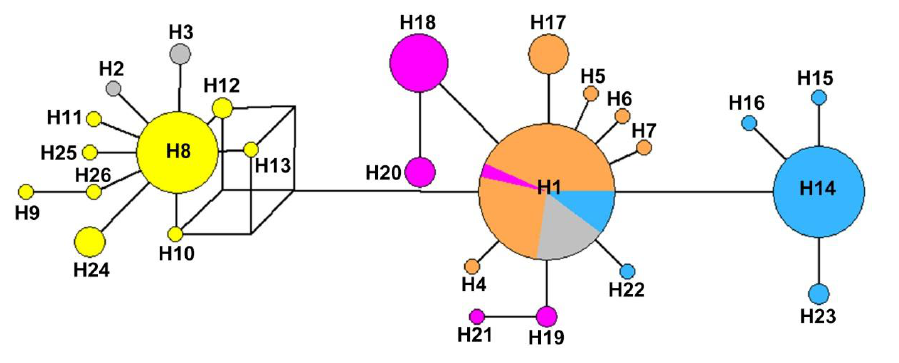
Figure 2. Haplotype network of Lycorma delicatula populations based on concatenated mitochondrial NADH dehydrogenase subunit 2 ( ND2 ) and NADH dehydrogenase subunit 6 ( ND6 ). Each circle represents a haplotype and sizes indicate the number of individuals. The haplotypes are identified by H1–H26. Except for H1, H8, and H14, the others are private haplotypes. The proportions of populations in haplotypes are indicated by the colors of circles. The colors are the same as the major clusters of populations inferred by STRUCTURE analysis when K = 4, except for gray (representing the haplotypes downloaded from GenBank).